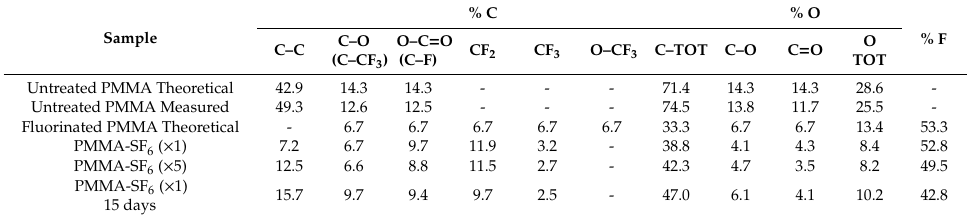
Table 1. X-ray Photoelectron Spectroscopy (XPS) data for untreated and plasma-treated PMMA samples.